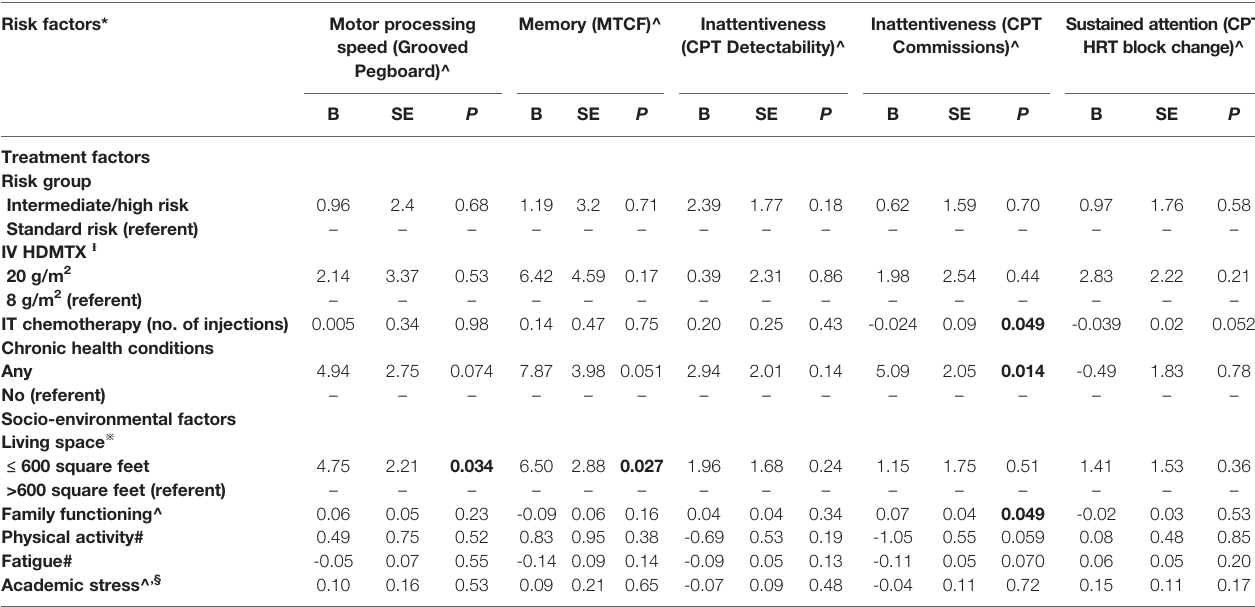
TABLE 2 | Factors Associated with Neurocognitive Outcomes. Risk